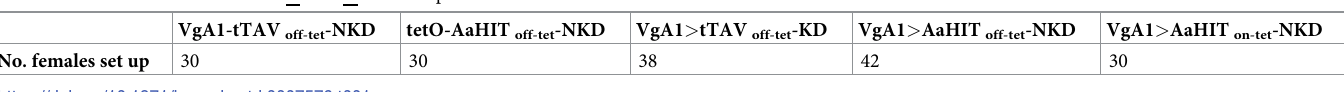
Table 1. Number of females from each cohort cage set up in Drosophila vials to assess egg-laying. NKD = those individuals which did N ot K nock D own in experiment 1. KD = those individuals which did K nock D own in experiment